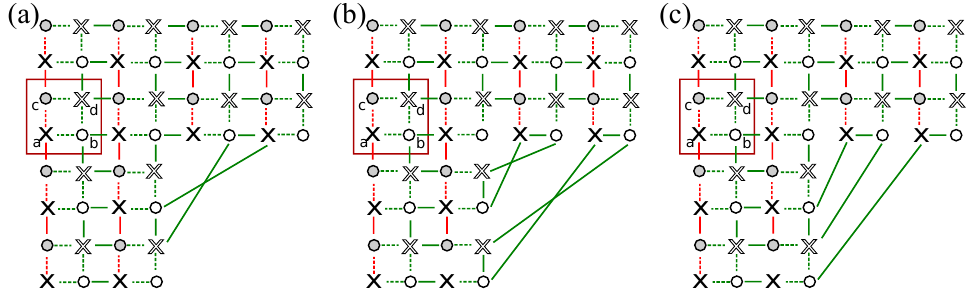
Figure B.3: Depiction of the model Hamiltonian for the magnetic second-order topo- logical insulator defined in Eq. (20). Crosses and dots denote chiral modes with opposite chirality as defined from an expansion of the Hamiltonian around k = π . Full (dashed) lines denote the hybridization at k and k z lines include a π phase. The unit cell is highlighted by a red square. In (a)–(c), we show three different possibilities of connecting the hybridizations at k the cut in the Volterra process to construct a